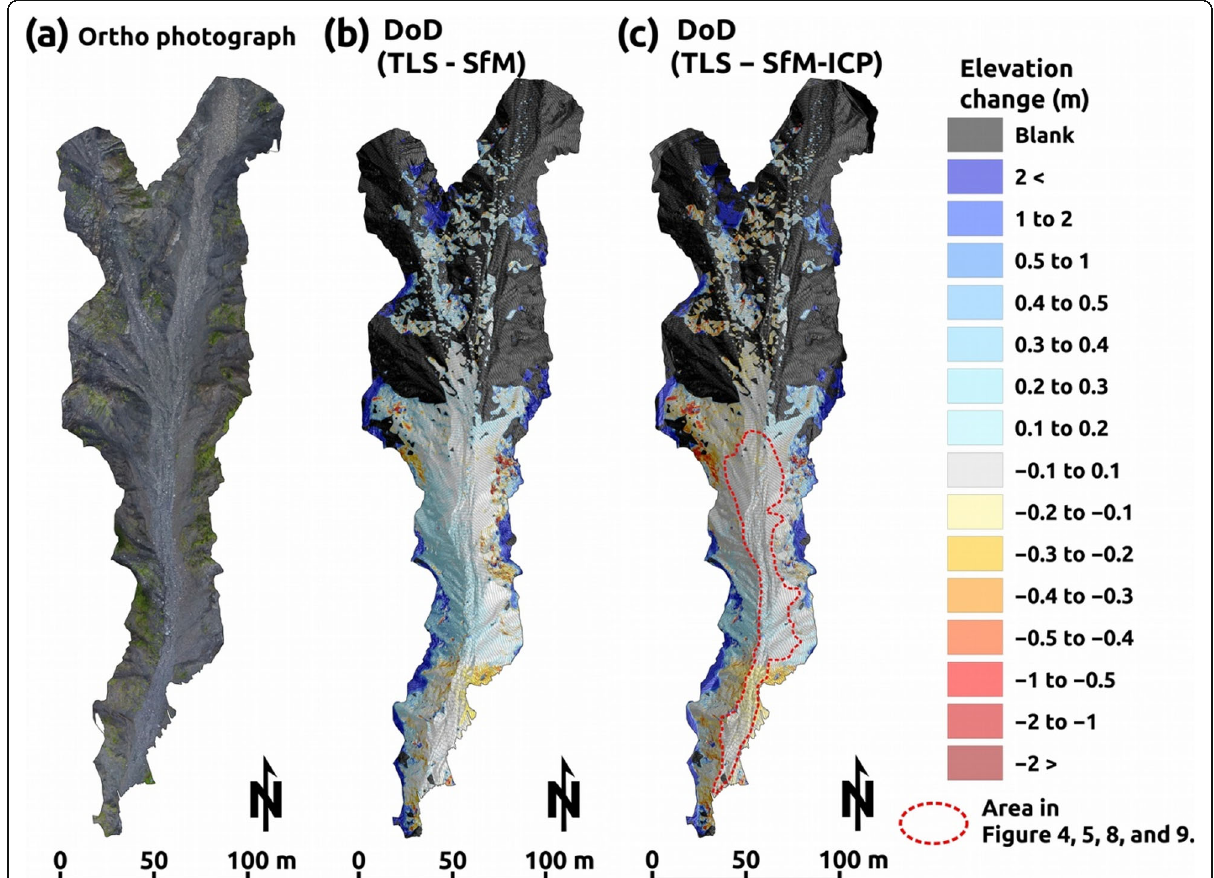
Fig. 3 Results of the UAV-SfM measurements. a Orthophotograph of the entire observation area and DEMs of the differences (DoD). b Between DEM TLS and DEM SfM . c Between DEM TLS and DEM SfM-ICP . Because both DoDs were computed such that DEM SfM or DEM SfM-ICP was subtracted from DEM TLS , the cold (positive value) and warm (negative value) colors indicate domains where the elevations of DEM SfM or DEM SfM-ICP are relatively high and low compared to DEM TLS , respectively. The TLS measurement focused on the downstream side of the initiation zone; therefore, there are blank domains indicated by the black color on the upstream side. The domain surrounded by the dotted red line indicates the area used for the